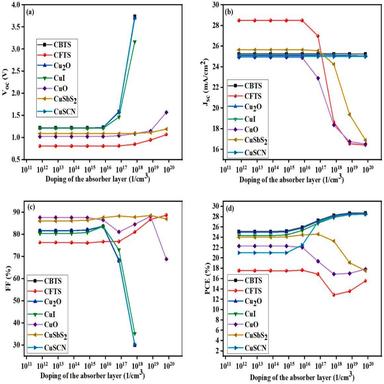
Doping density (NA) of the absorber layer versus SC performance parameters with ETL ZnSe.